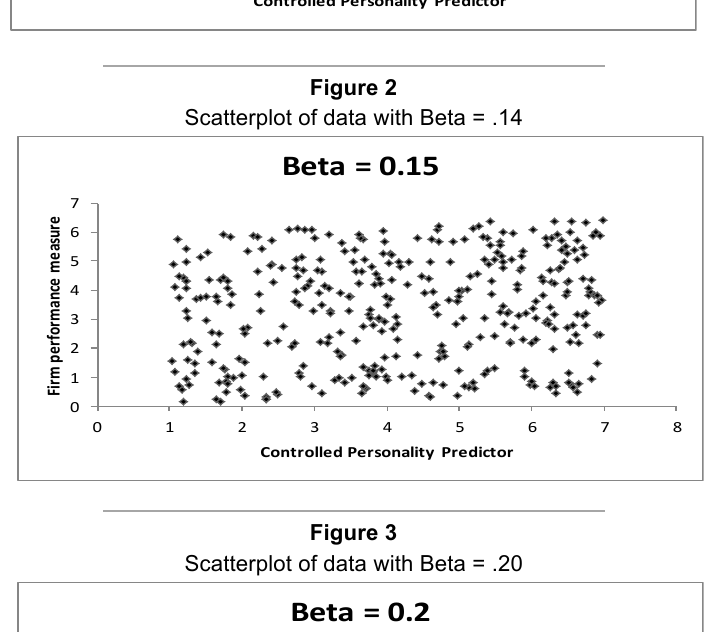
Scatterplot of data with Beta =